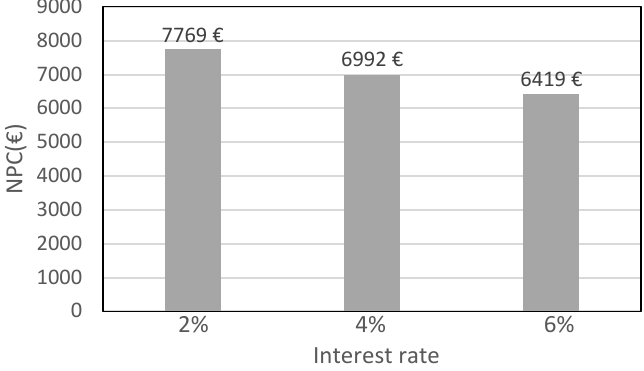
Figure 12. PV-only systems. Effect on the NPC of the interest rate.